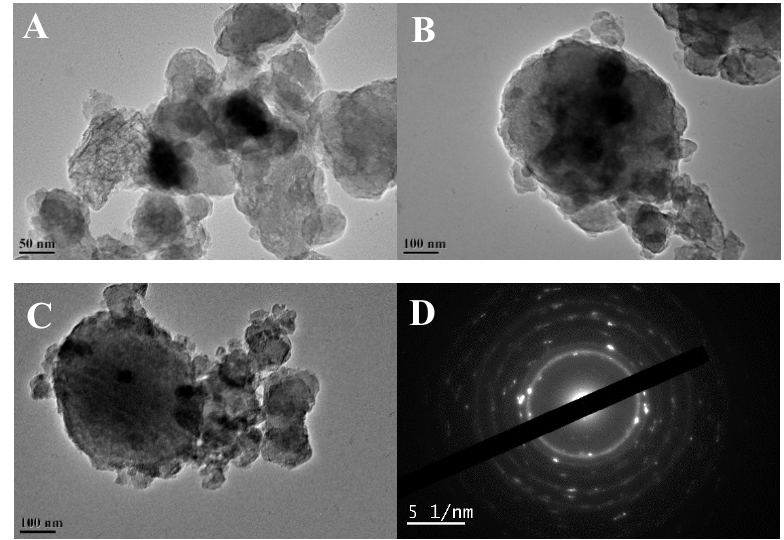
Figure 5. TEM micrographs of the samples: ( A ) NiP/H β calcined at 200 °C, ( B ) NiP/H β calcined at 300 °C, ( C ) NiP/H β calcined at 400 °C and ( D ) SAED picture of NiP/H β calcined at 400 °C.